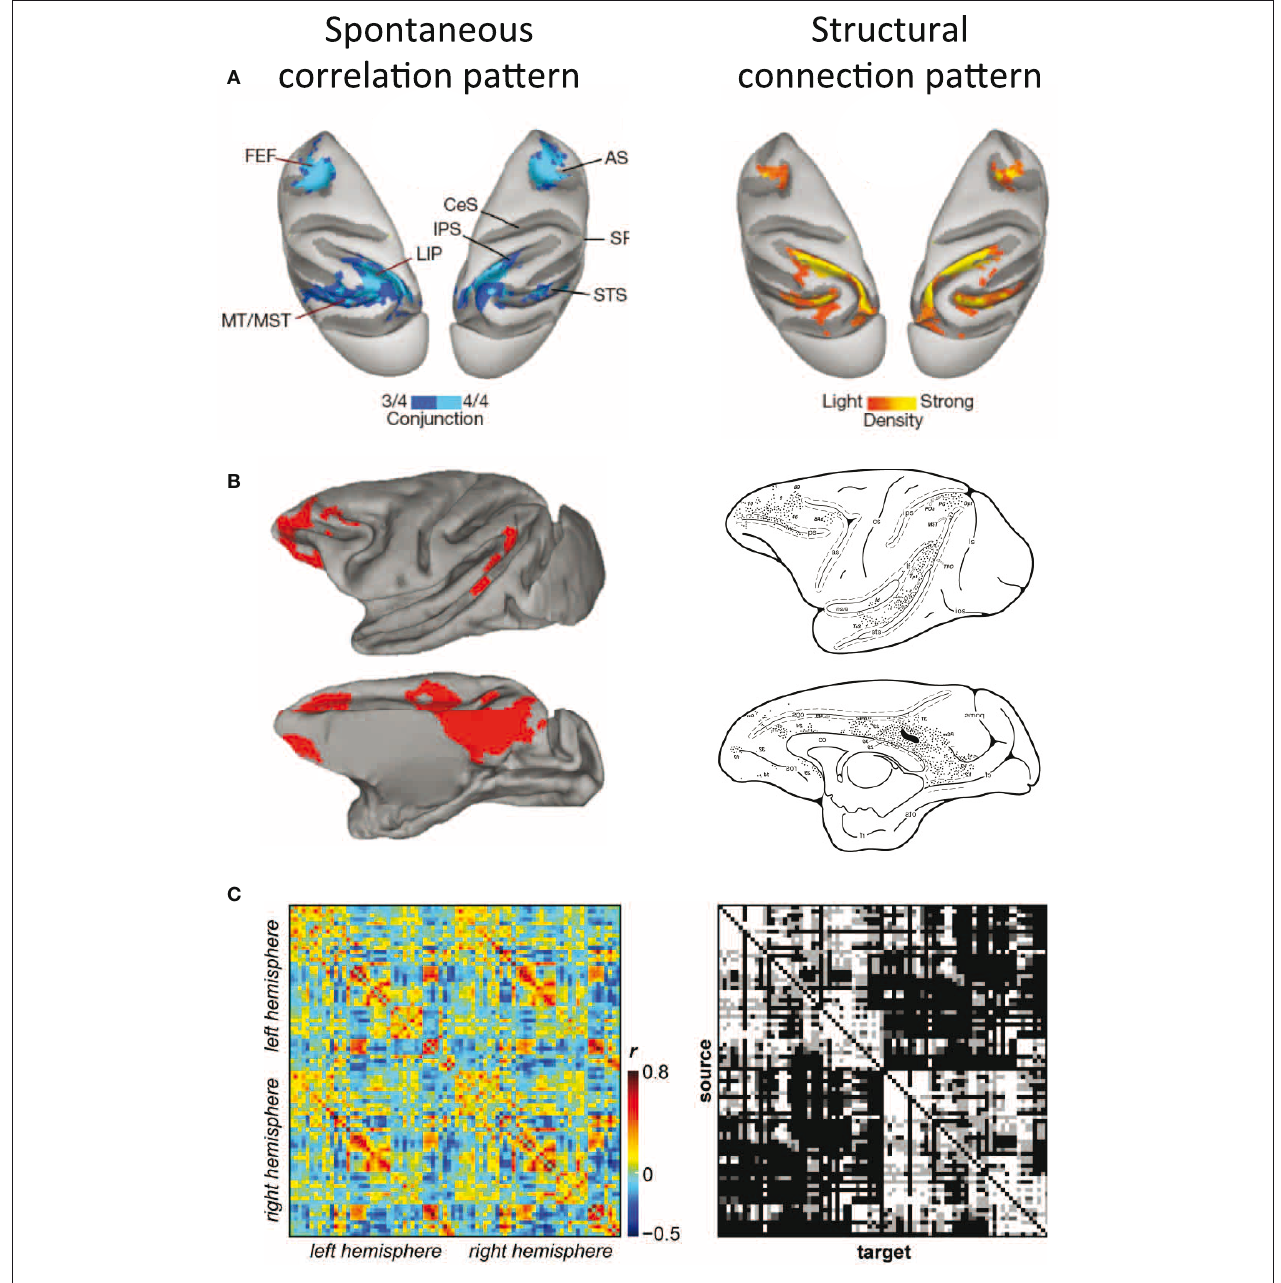
FIGURE 6 | Correspondence of functional and structural connectivity patterns in the macaque. (A) Conjunction map of functional connectivity the macaque oculomotor system (left) and density of cells labeled by retrograde tracer injections into right LIP (right) displayed on dorsal views of both hemispheres. (B) Correlation map of functional connectivity of macaque posterior cingulate cortex (left) and the structural connectivity patterns injection of tracers within a location comparable to